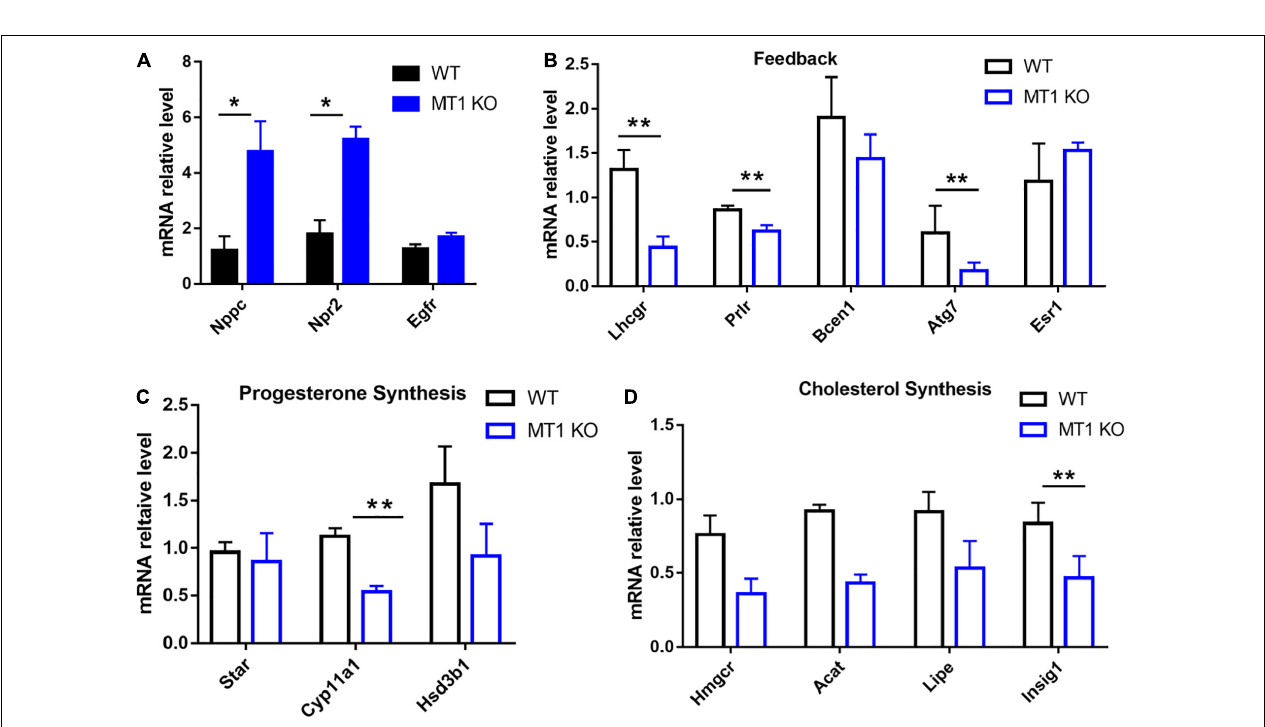
FIGURE 5 | Effects of MT1 KO on the expression of Nppc / Npr2 and genes related to progesterone synthesis. Nppc / Npr2 are genes regulating oocyte maturation and progesterone synthesis in mouse GV granulosa cells. (A) Nppc / Npr2 and Egfr . (B) Gene-related feedback. (C) Gene-related progesterone synthesis. (D) Gene-related cholesterol biosynthesis. Data represent the mean with SEM. (* P < 0.05, ** P < 0.01) vs respective groups determined by one-way ANOVA followed by Tukey post hoc comparisons ( n = 3).